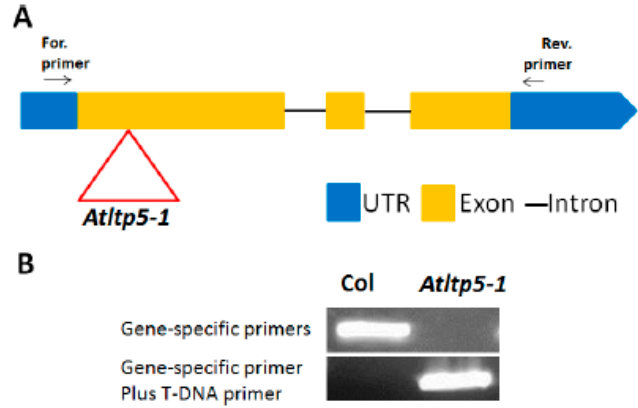
Figure 8. Knock-out mutant for LTPg5 , ( A ) The T-DNA insertion (inverted triangle) in ltp5-1 (SAIL_329_H03) ( B ) PCR with DNA from homozygous mutant and Columbia (Col).